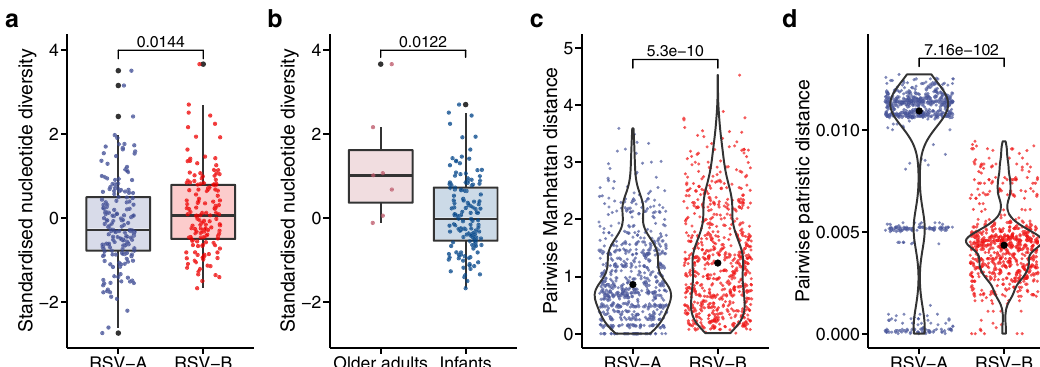
Fig. 2 Z -score standardised pairwise nucleotide diversity and pairwise genetic distances. a Comparison of standardised pairwise nucleotide diversity between 175 RSV-A and 144 RSV-B samples. b Comparison of standardised pairwise nucleotide diversity of RSV-B between seven adult samples and 137 infant samples. RSV-A isolates were excluded from this comparison because only one adult had RSV-A infection. c Comparison of pairwise Manhattan distances. d Comparison of pairwise patristic distances. Only pairwise distances between samples from the second sequencing batch, the same country, the same season and different participants were included in c and d (650 RSV-A pairs and 656 RSV-B pairs). Each dot represents an individual sample in a and b , and a sample pair in c and d . Two-tailed Mann – Whitney U -tests were used to evaluate the signi fi cance of the differences. P values are shown above the plots. For a and b , the centre line of each box denotes the median; box limits, the fi rst and third quartiles; whiskers, the highest and lowest values within 1.5 times the interquartile range from the box limits and outlying points, outliers. For c and d , the violin plots summarise the distribution of the data, and the black dots denote the median value of each